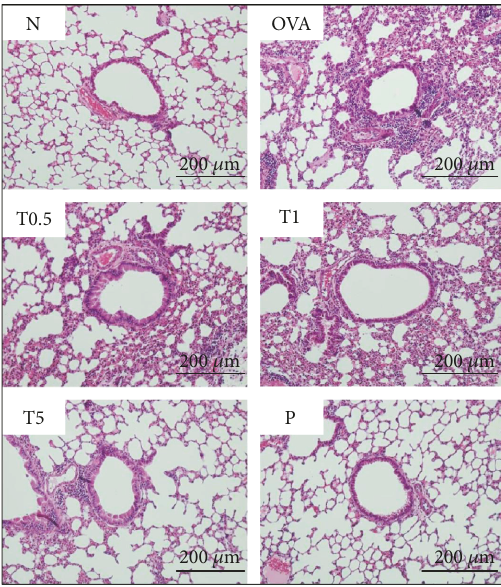
Figure 2: E ff ect of tomatidine on eosinophil in fi ltration (HE staining) in lung tissue (200x magni fi cation).